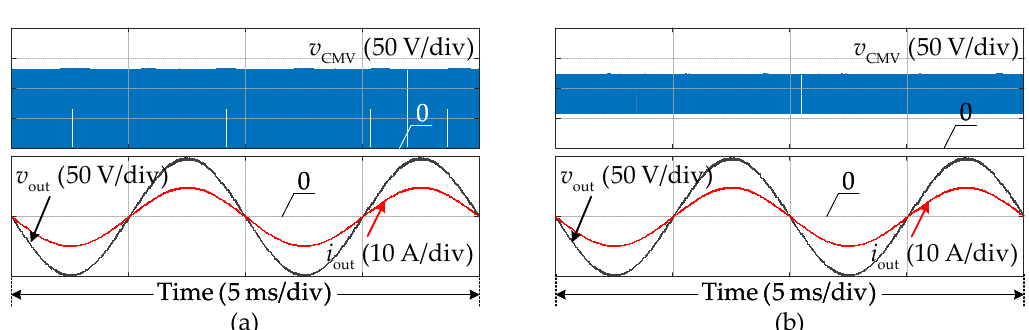
Figure 7. Simulation results of the CMV v cmv , output voltage v out and output voltage i out when the NSPWM strategy is used in ( a ) the conventional three-phase qZSI system and ( b ) the modified three-phase qZSI system [Time (5 ms/div)].